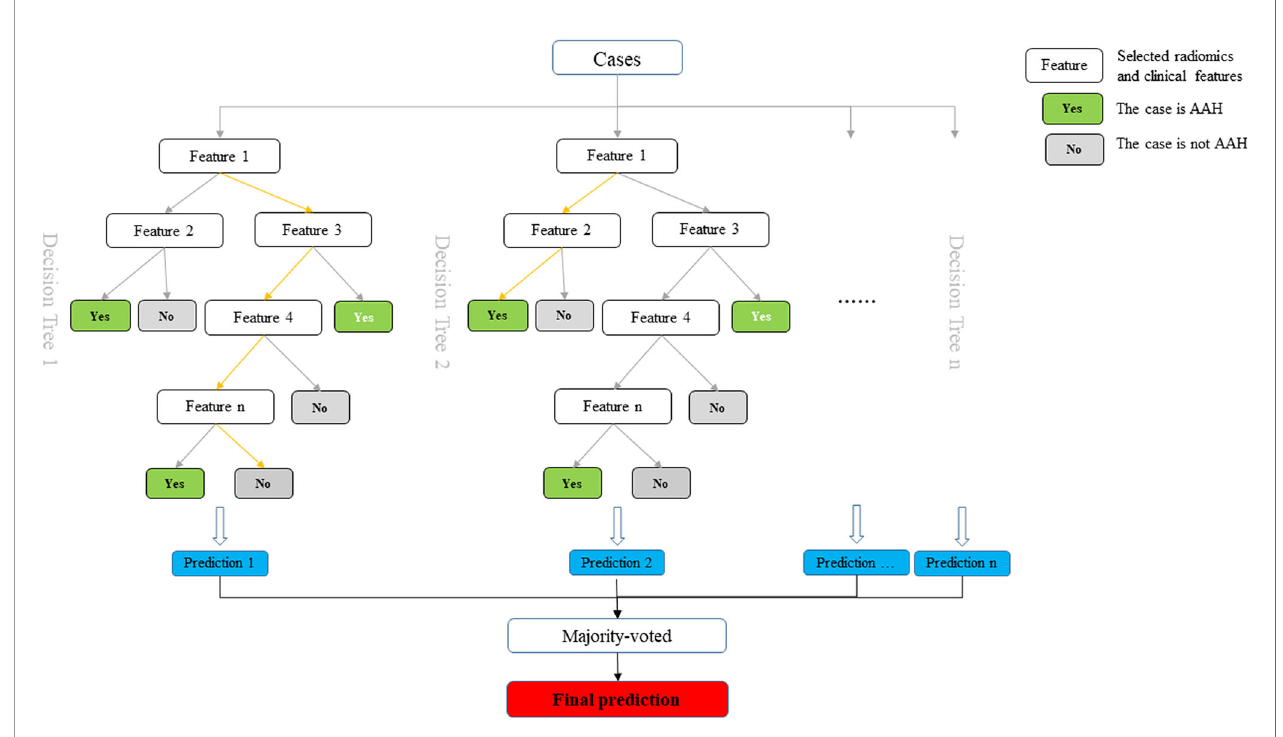
FIGURE 3 | The diagram of established prediction model based on random forest classi fi